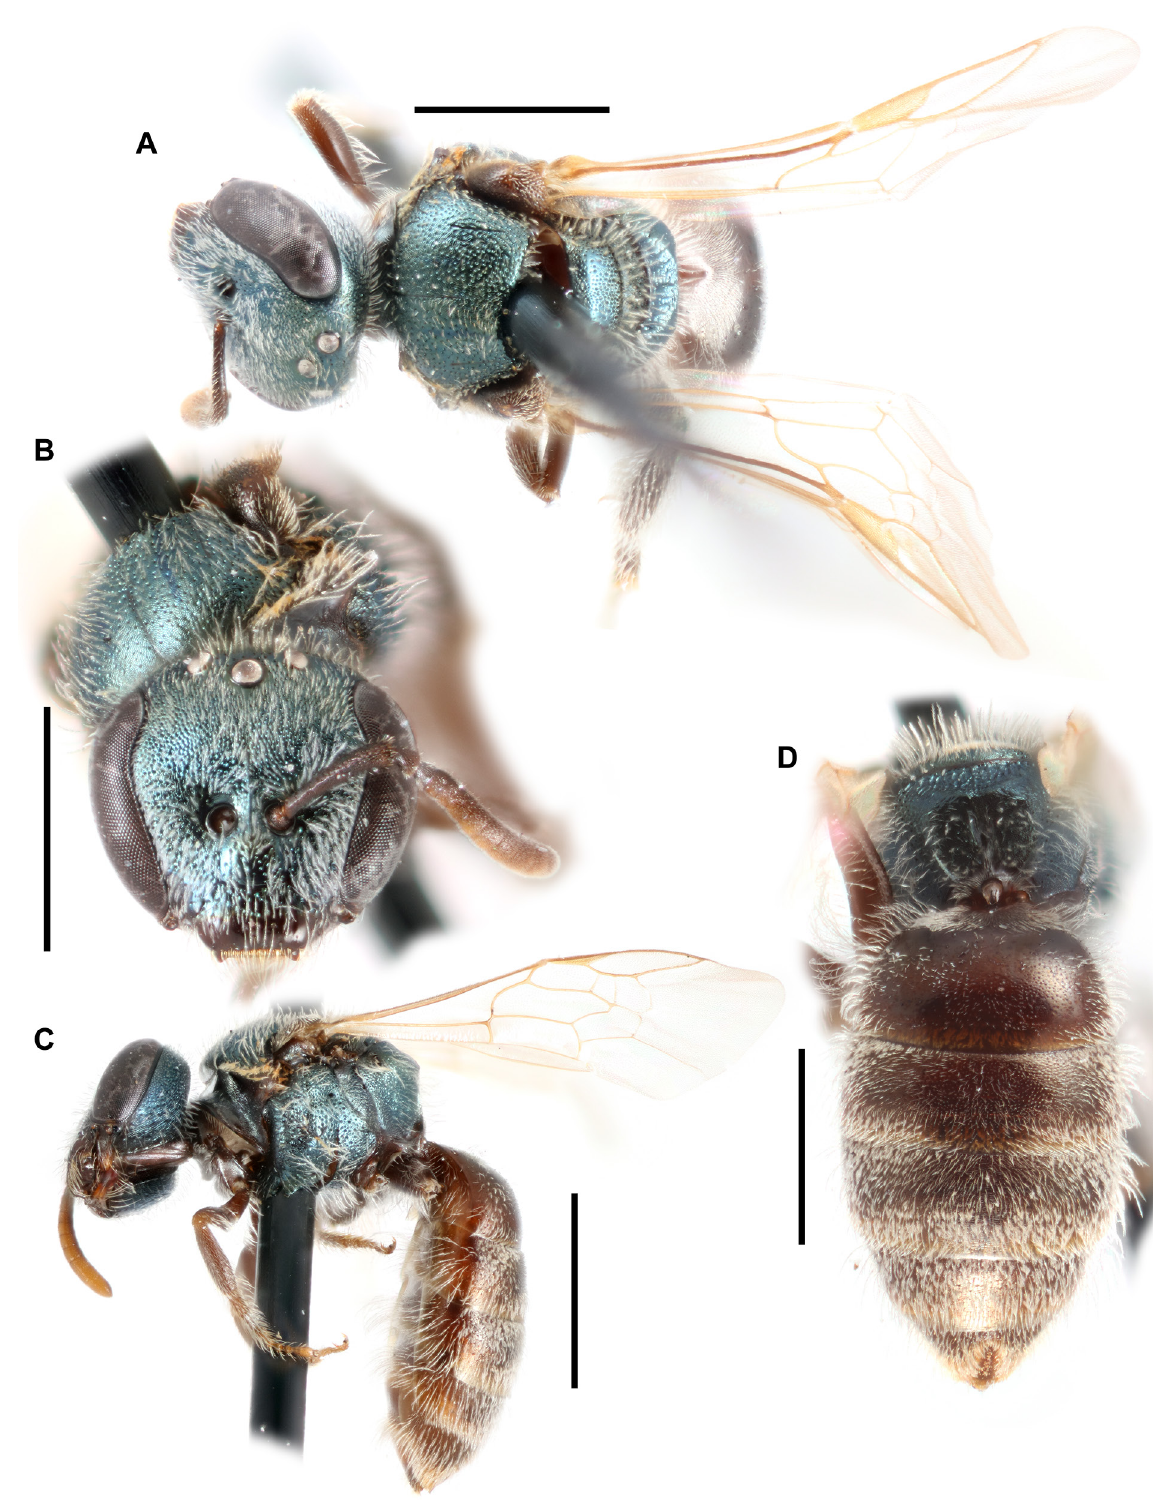
Fig. 9. Lasioglossum ( D .) coactus (Cresson, 1872), ♀. A . Dorsal habitus. B . Face. C . Lateral habitus. D . Metasoma and propodeum. Scale bars = 1